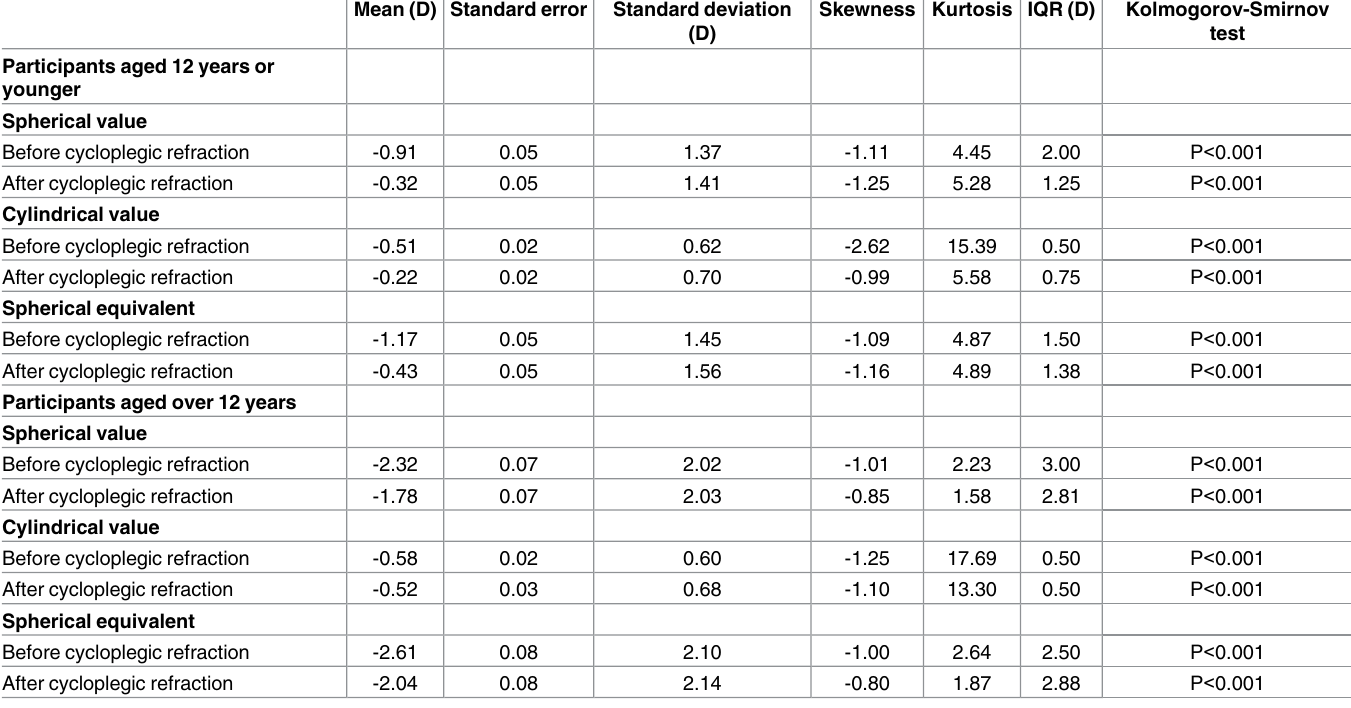
Table 1. Distributions of spherical value, cylindrical value and spherical equivalent before and after cycloplegic refraction. Mean (D) Standard error Standard deviation Skewness Kurtosis IQR (D)